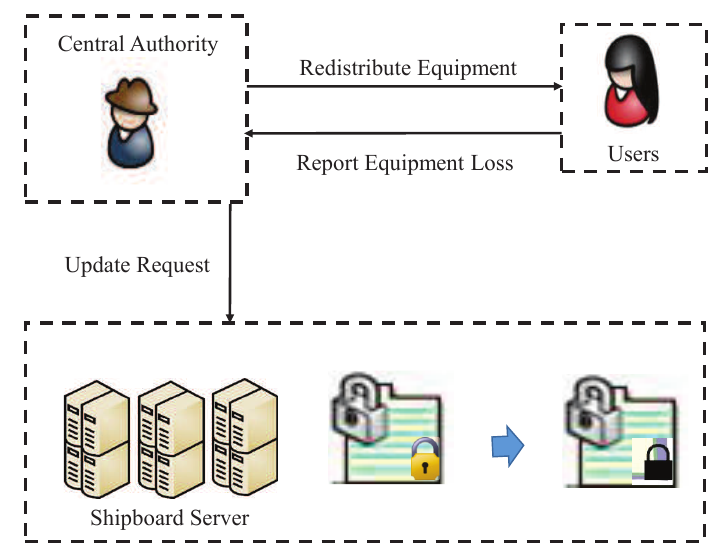
Figure 2. The process of ciphertext update and security equipment